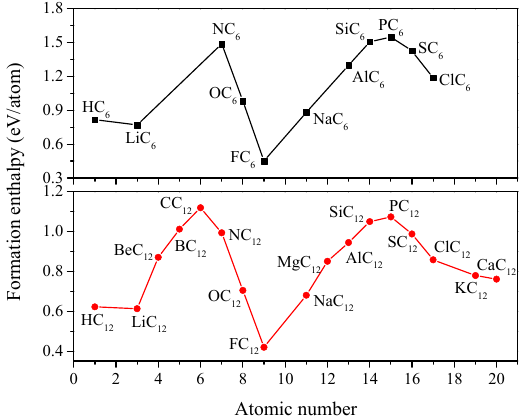
Figure 2. Formation enthalpy of XC 6 and XC 12 .